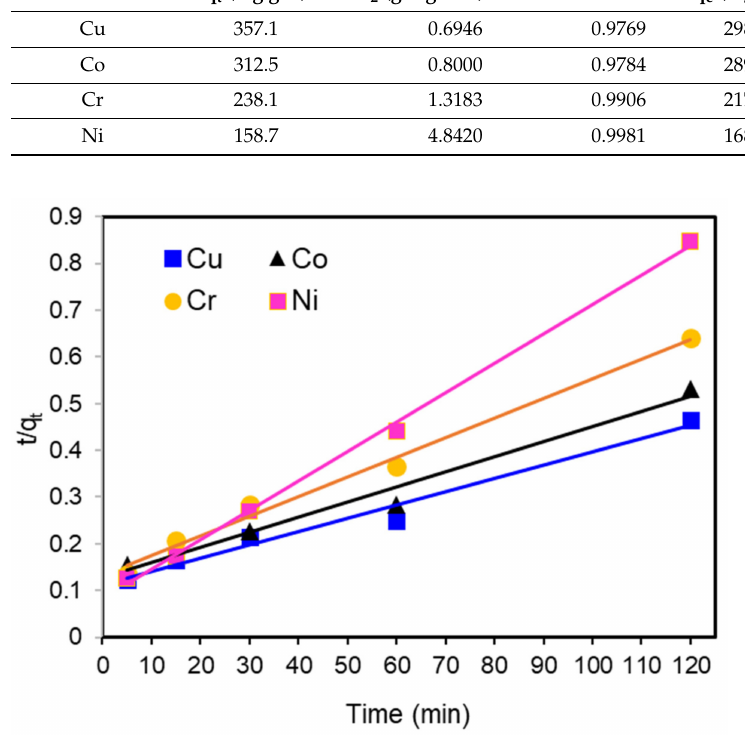
Figure 5. Pseudo-second order kinetic plots by poly(amidoxime)